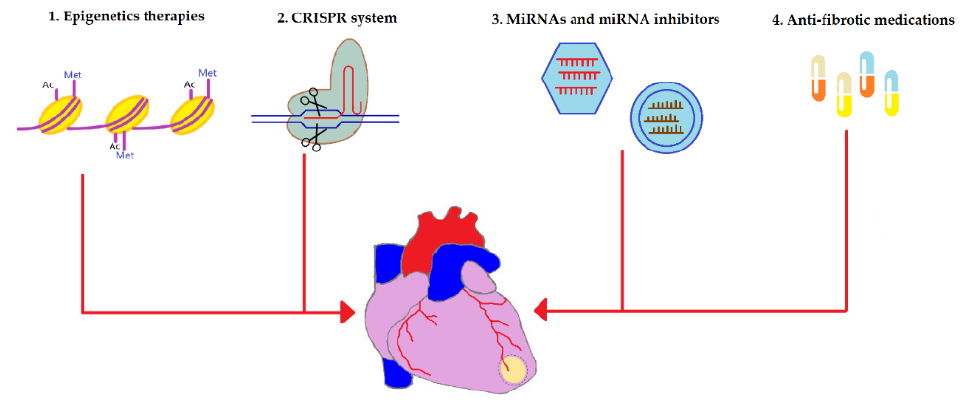
Figure 2. An overview of the novel strategies utilized to alleviate fibrotic remodeling after cardiac diseases. Multiple cardiac pathologies tend to terminate in the replacement of contractile myocardium with the fibrous tissue, one of these diseases is myocardium infarction (infarction area is depicted in yellow). Novel anti-fibrotic therapies target various levels of the pathogenesis of cardiac